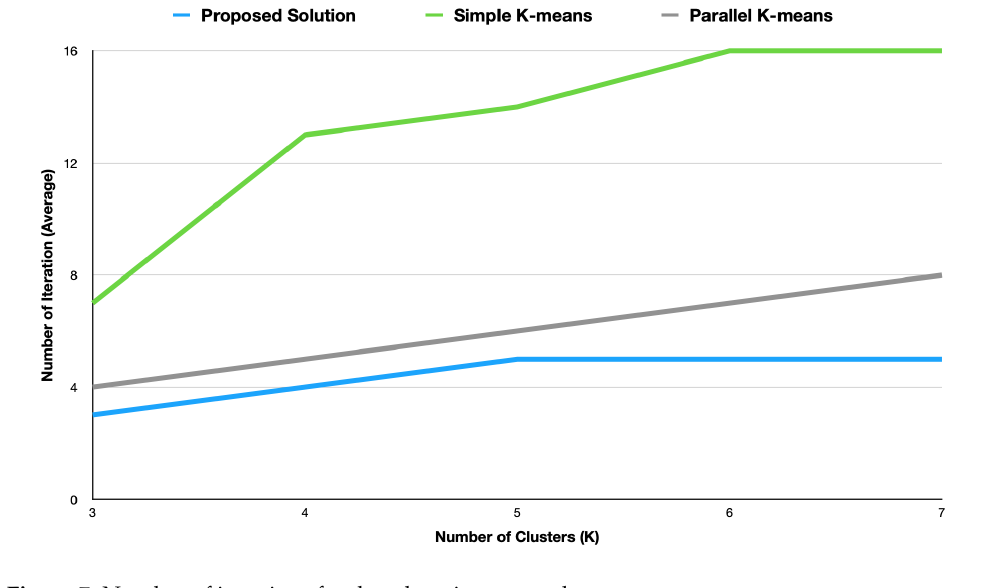
Figure 7. Number of iterations for the education sector dataset.